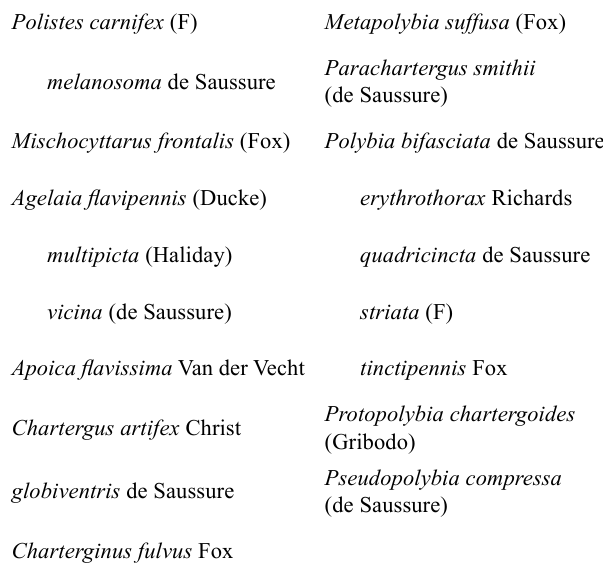
Table 2. List of the 19 species of social wasps recorded in Goiás State within 20 kilometres of the Federal District of